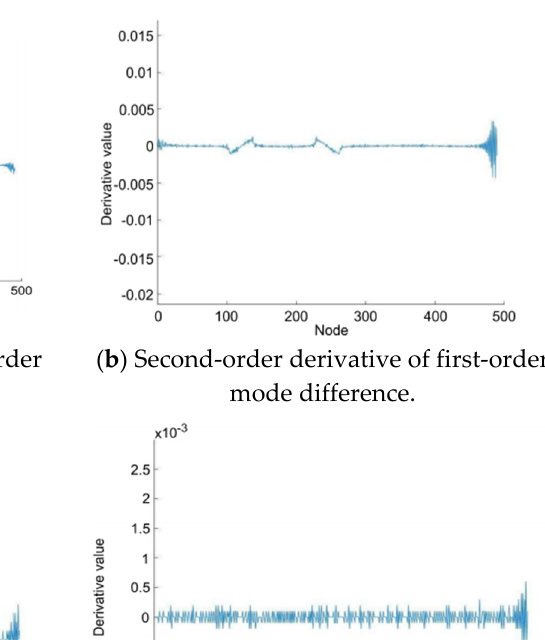
Figure 26. First-order and second-order derivatives of the differences of the first five orders of modes under Conditions 1 and 3.